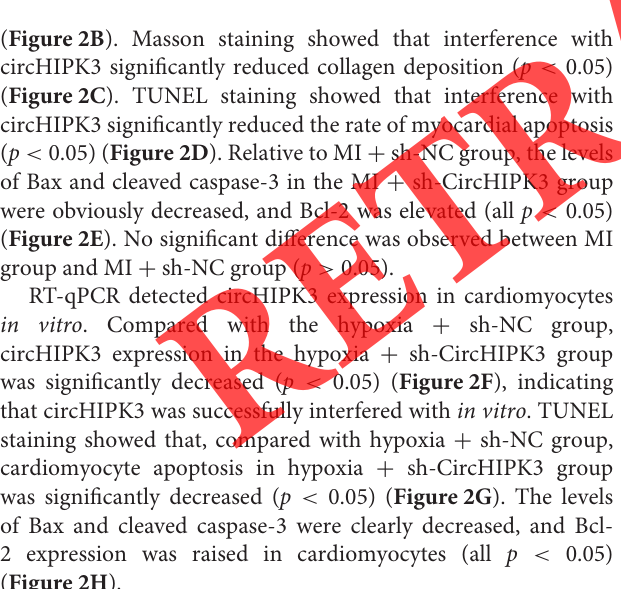
FIGURE 1 | CircHIPK3 is highly expressed in the mouse model and cell model of myocardial infarction (MI). (A) Echocardiography was used to detect the changes of cardiac function-related indexes after modeling, n = 10. (B) 2,3,5-Triphenyltetrazolium chloride staining was used to detect the infarct area, n = 10. (C) TUNEL staining was used to detect apoptosis after MI in vitro . (D) RT-qPCR was used to detect the expression of CircHIPK3 in myocardial tissue of MI mice and in vitro cell model. The value in the figures is the measurement data, which is expressed as mean ± standard deviation. The comparison between two groups was analyzed by independent-sample t -test. *compared with sham group, p < 0.05; # compared with control group, p < 0.05. The experiment was repeated three times.